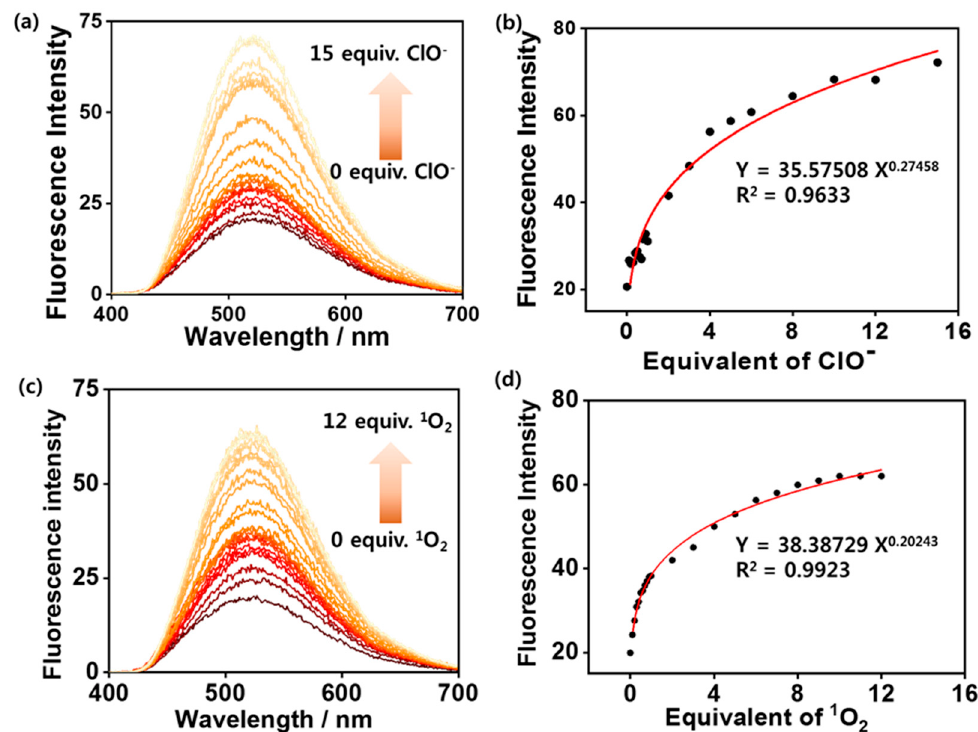
Figure 4. Fluorescence spectra (Excitation wavelength: 360 nm for probe 1 ) of 1 (25 μ M) in the presence of various concentrations of ( a ) ClO − (0–375 μ M) and ( c ) 1 O 2 (0–300 μ M) in DMSO/H 2 O (1/99, v / v %). Plot for fluorescence intensity of 1 upon addition of ( b ) ClO − and ( d ) 1 O 2 .